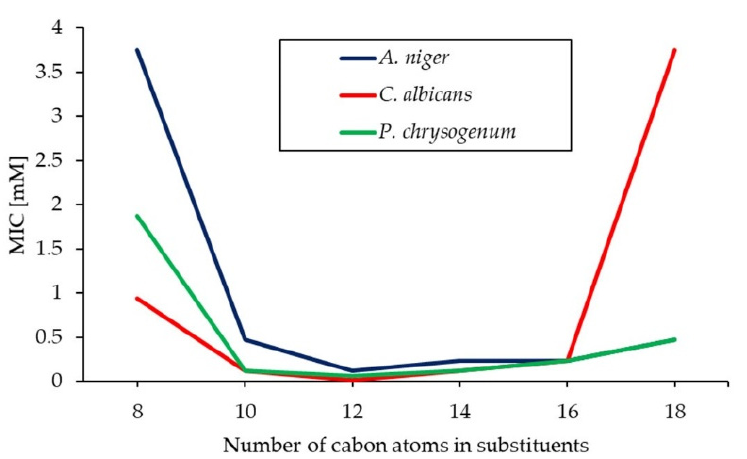
Figure 3. Quasi-parabolic dependency of the antifungal activity against A. niger, C. albicans and P. chrysogenum on the hydrocarbon chain length for n - O-n .